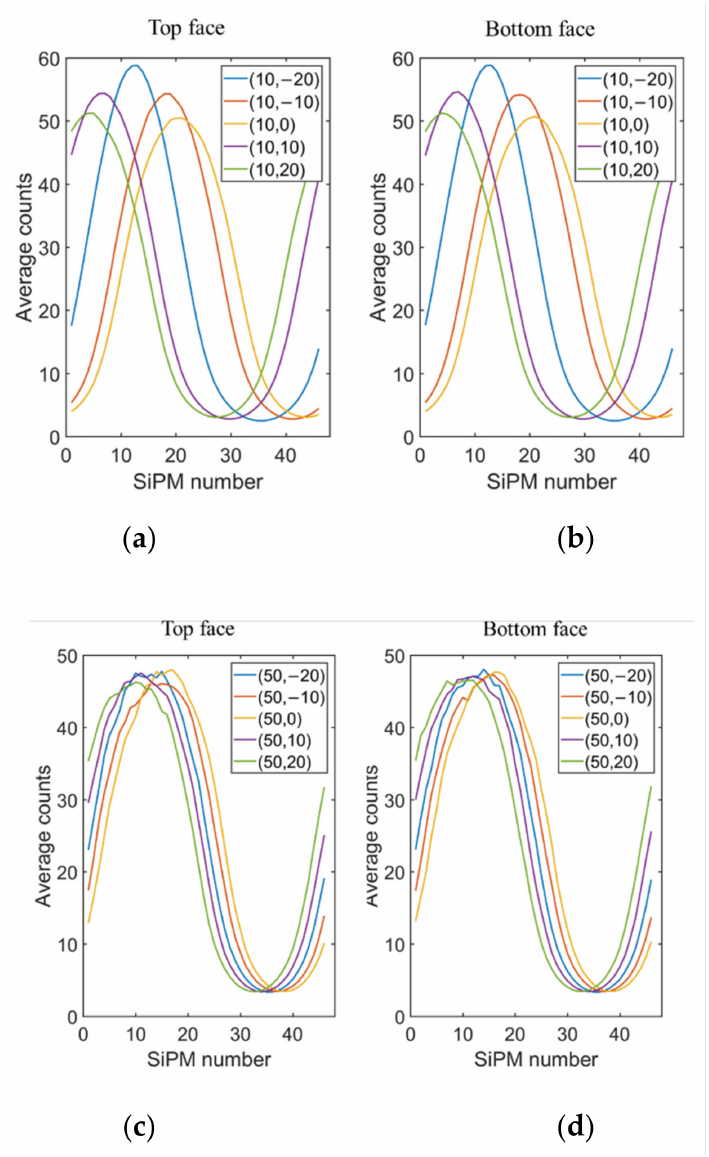
Figure 8. Energy distribution statistics of channels at: ( a ) top face and ( b ) bottom face for X = 10 cm, and ( c ) top face and ( d ) bottom face for X = 50